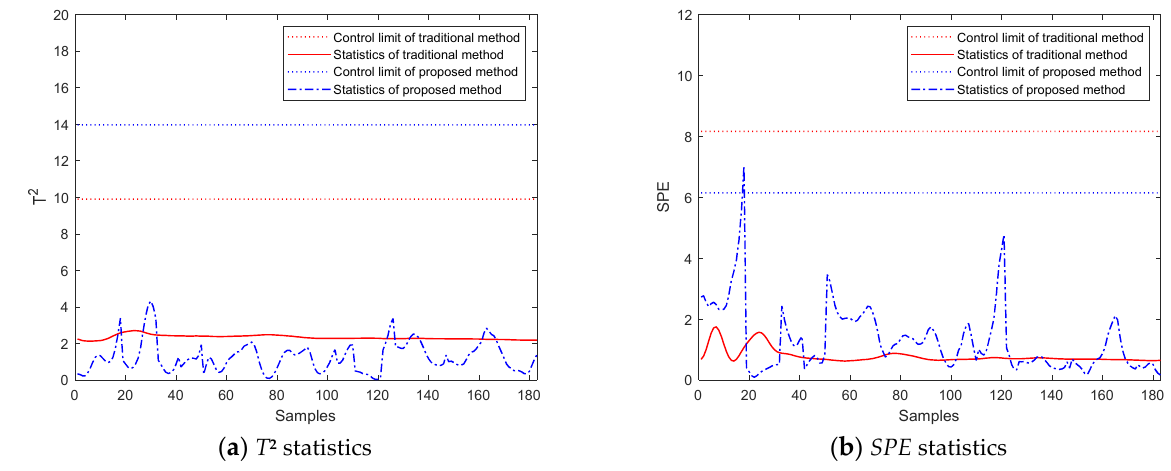
Figure 8. Online monitoring of the cooling phase.